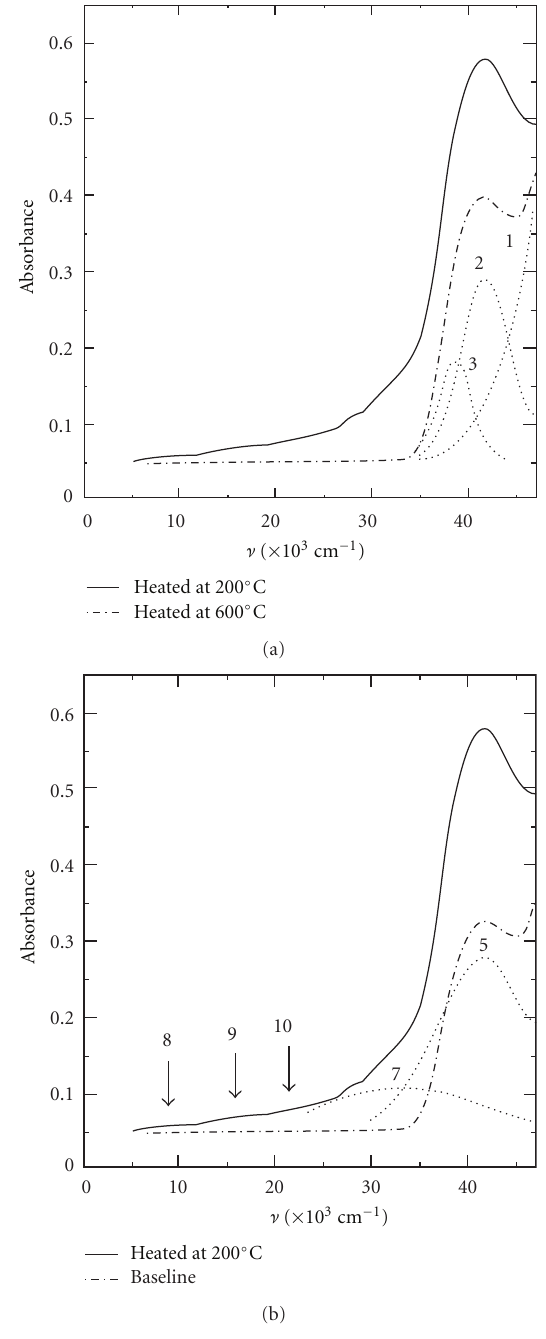
Figure 2: Optical absorption of irradiated thin sample of topaz heated at 200 ◦ C and 600 ◦